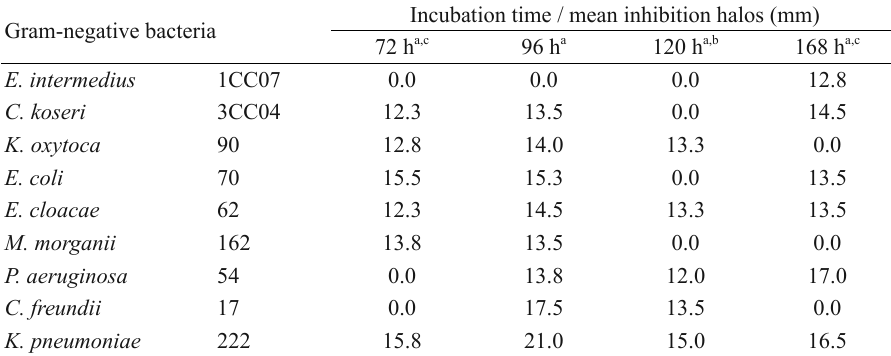
Results of the optimization of the production of active R18(6) metabolites using 1% glucose as carbon source and different incubation